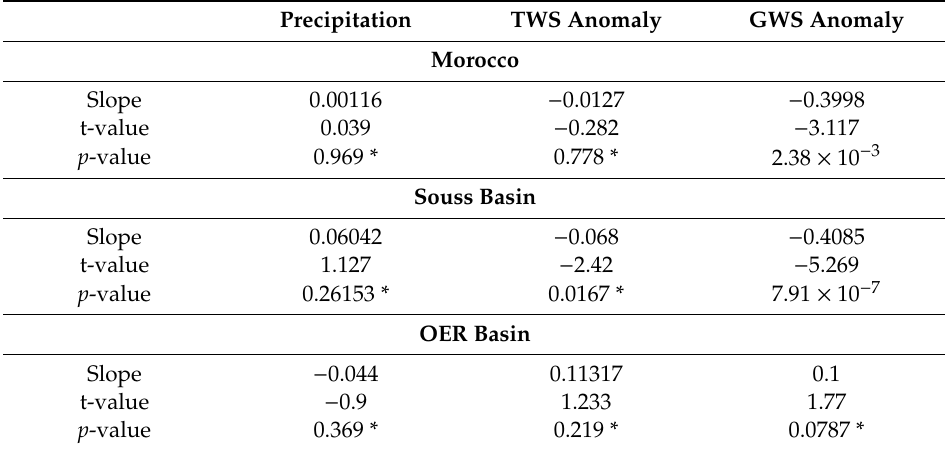
Table 1. Statistical analysis of the trends in precipitation, TWS anomaly, and GWS anomaly for Morocco and the Souss Basin. TWS anomaly in Souss Basin and GWS anomaly in both the Souss Basin and Morocco shows statistically significant decreasing trends ( p -value < 0.05).